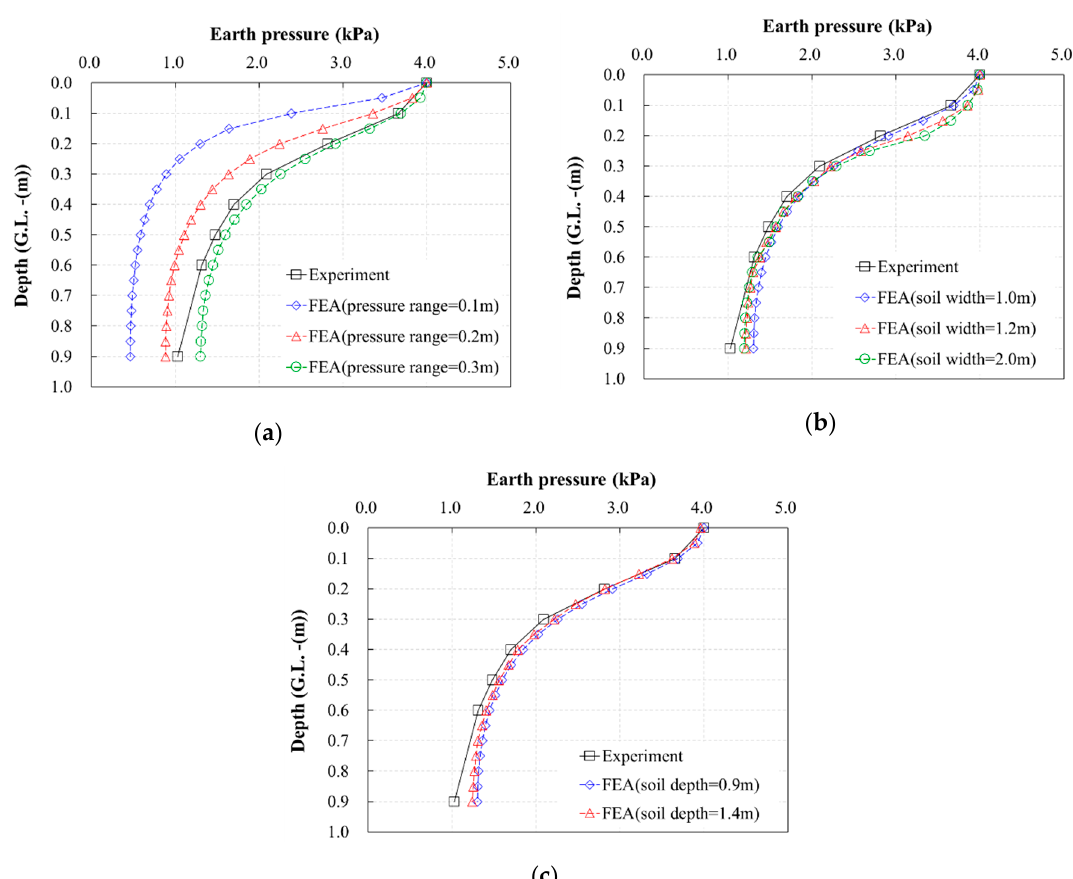
Figure 7. Analysis results for model verification: ( a ) e ff ect of the pressure range; ( b ) e ff ect of the soil length; ( c ) e ff ect of the soil